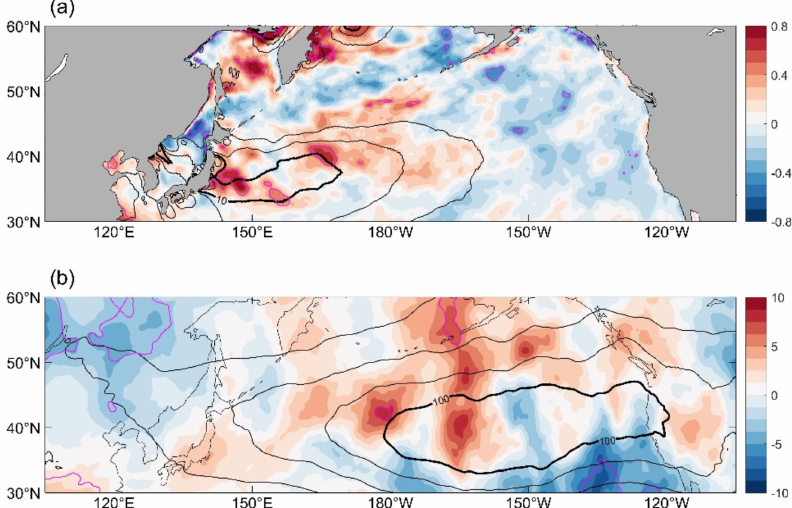
Figure 8. ( a ) The estimated EGR response (shading, unit: 10 − 6 s − 1 ) in DJF onto the KEI 2 months earlier and the climatological EGR (contours at 2 × 10 − 6 s − 1 intervals) in DJF at the 850-hPa level. The EGR at 10 − 5 s − 1 is marked by the thick black contours. The EGR over the continent is omitted because of the noisy impacts from the topography. ( b ) The estimated storm-track response (shading, unit: m 2 s − 2 ) in DJF onto the KEI 2 months earlier and the climatological storm track (contours at 20-m 2 s − 2 intervals) in DJF at the 300-hPa level. The storm track at 100 m 2 s − 2 is denoted by the thick black contours. Magenta contours represent where the atmospheric anomalies are significant at the 90% confidence